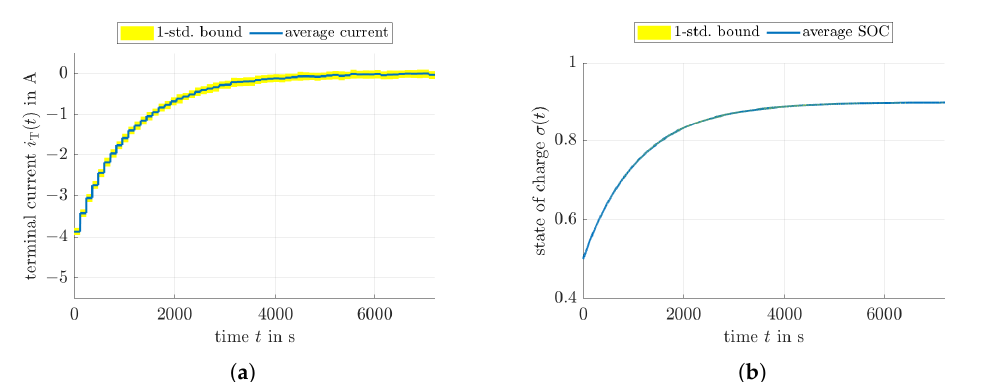
Figure 9. Feedback control under the influence of state reconstruction noise. ( a ) Terminal current i T ( t ) ; ( b ) SOC σ ( t ) .